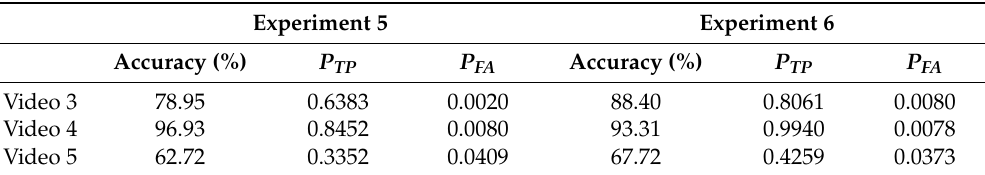
Figure 8. Example showing the pre-processing step. The image on top shows a frame being scanned by a sliding window, while the image on the bottom highlights a region (marked by blue rectangle), centered around a window (marked by cyan rectangle) selected for further processing. Table 5. Classification results for the second dataset at 640 × 480 and 1280 × 720 resolutions (Experiments 5 and 6).